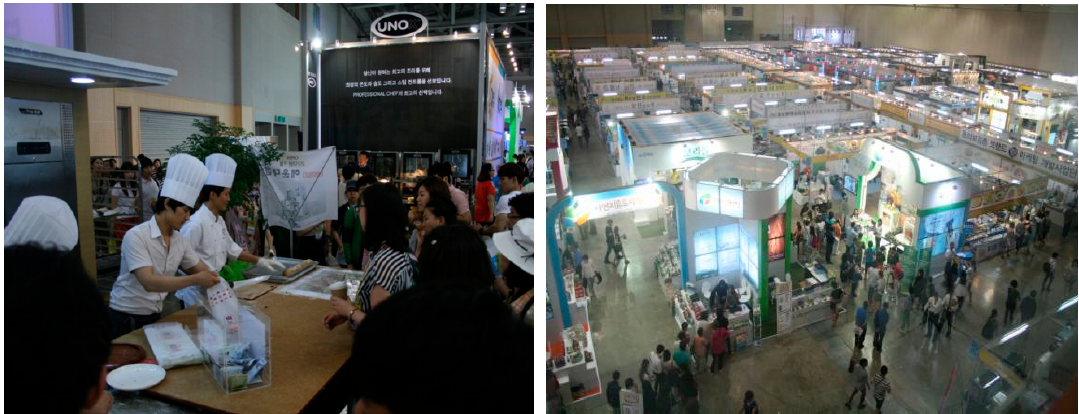
Figure 2. The pictures of the 22nd Busan International Food Expo.